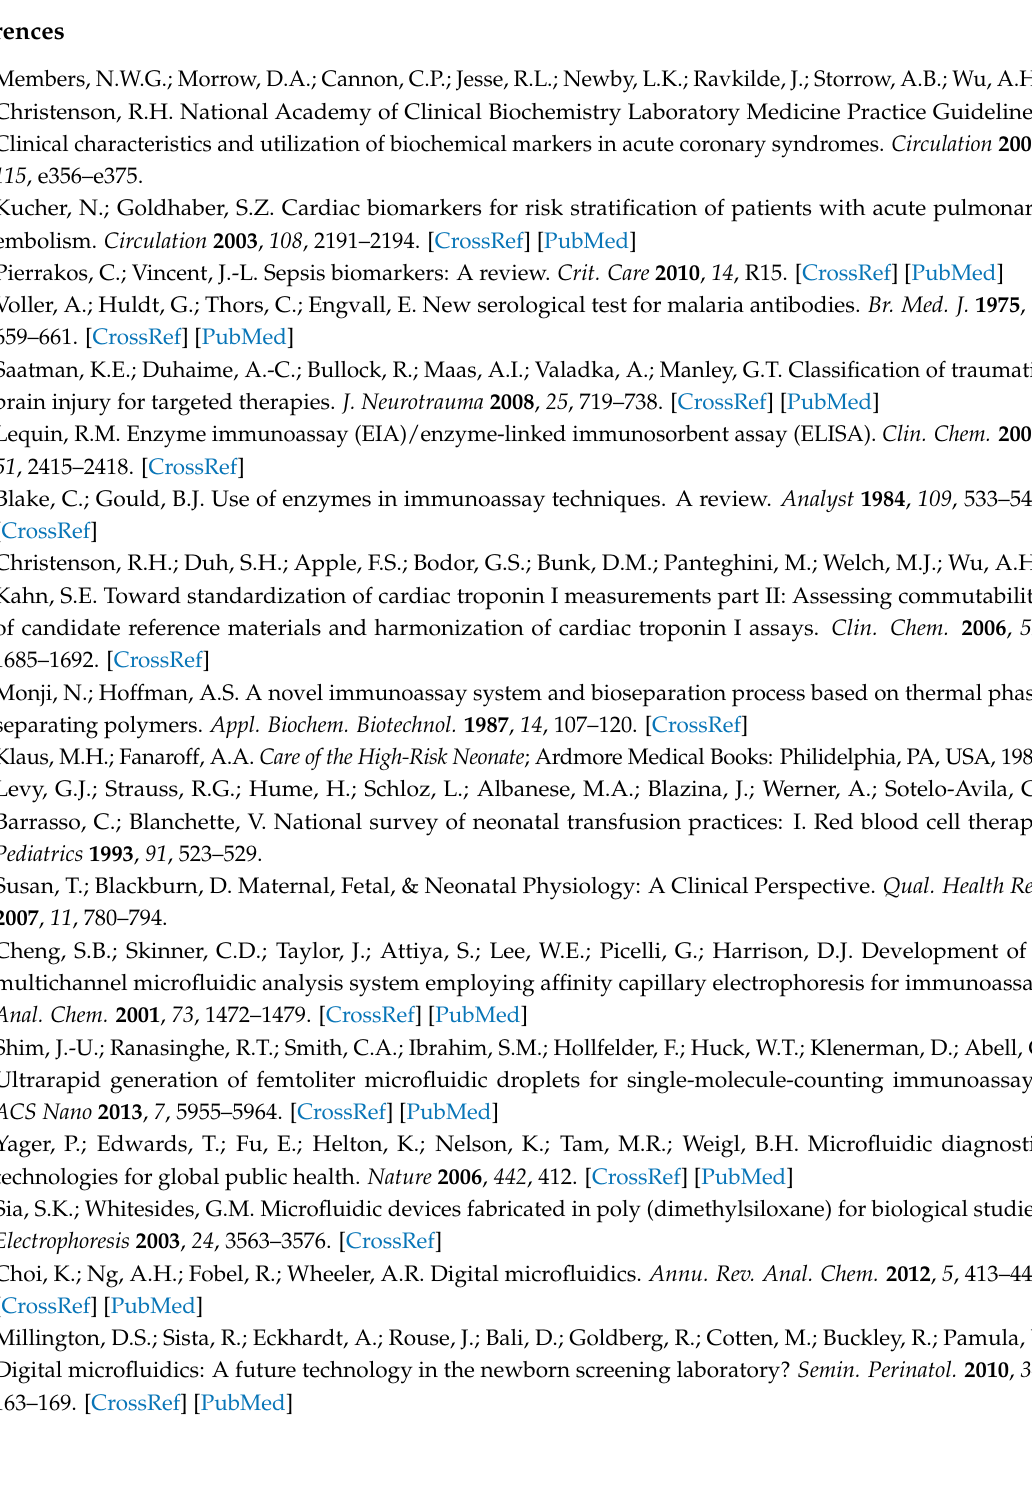
detection antibody-HRP conjugates in PBS. Figure S3: Colorimetric image analysis in CIE color space. A shift in the color space toward yellower region corresponds to the higher concentration of IL-6